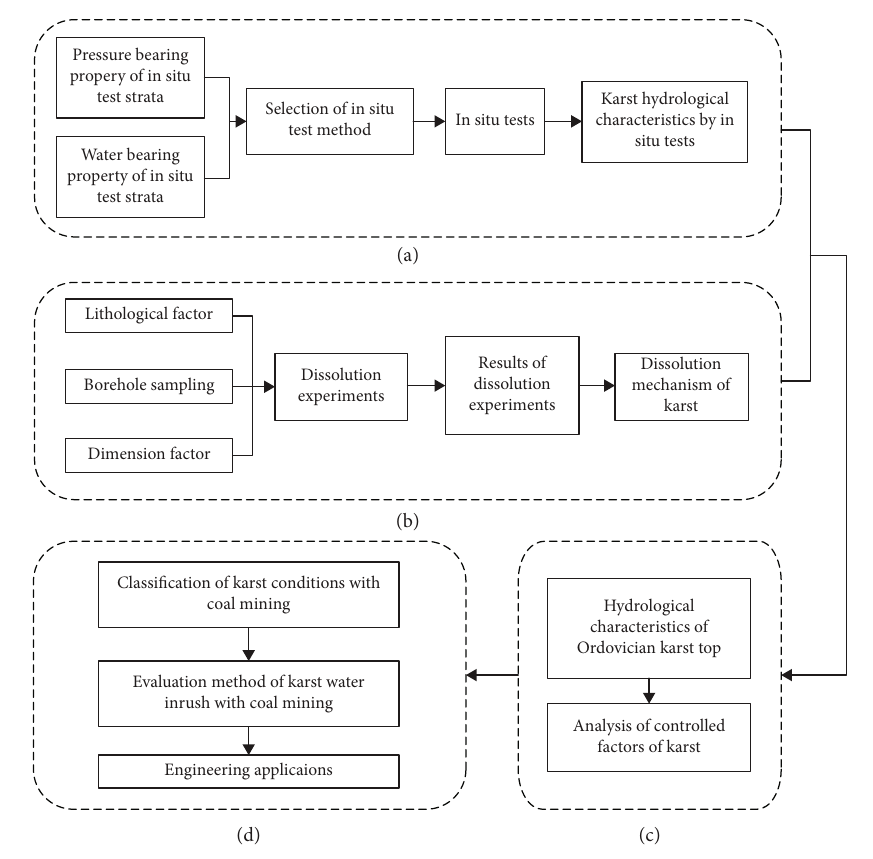
Figure 3: The study route of this